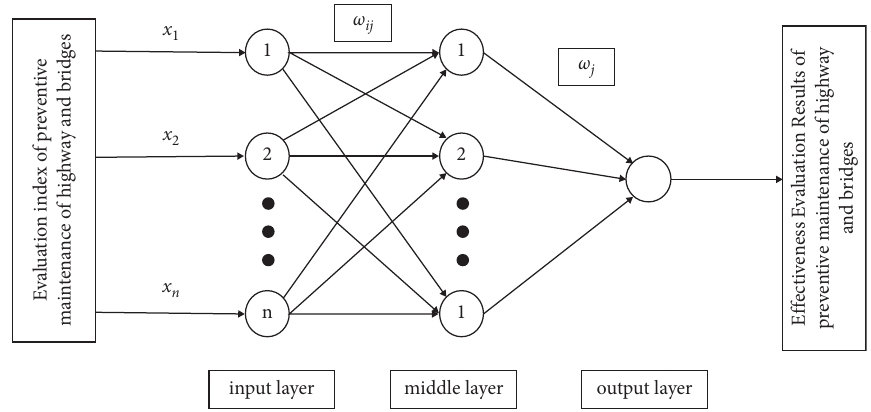
Figure 2: BP neural network